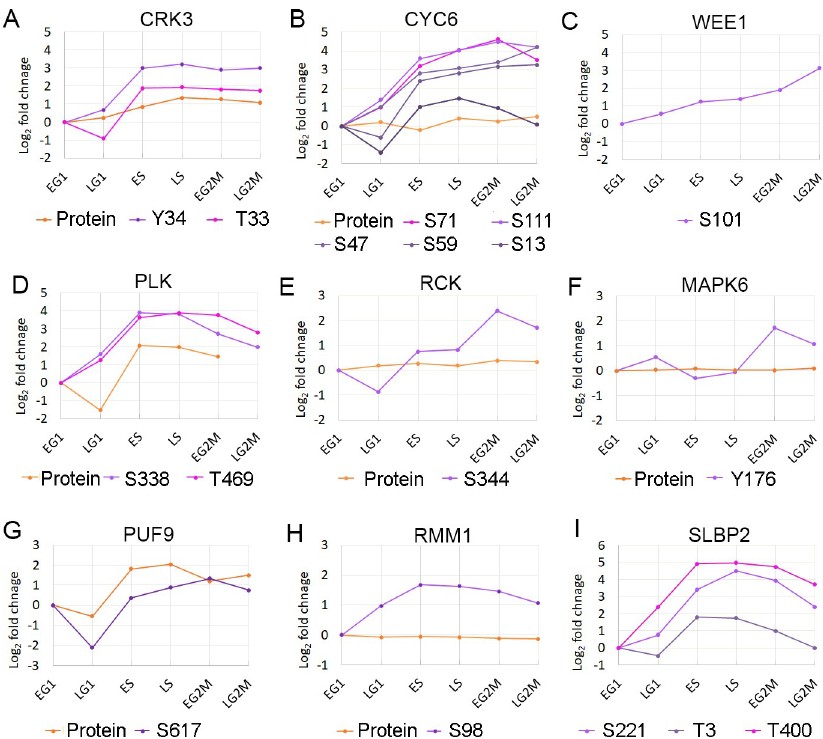
Fig 5. Cell cycle regulated protein kinases and RNA binding proteins. Changes in protein or phosphorylation site abundance relative to EG1. Orange–protein; Purple hues–phosphorylation sites. A. CRK3 protein, Y34 and T33. B. CYC6 protein, S13, S17, S111, S47 and S59. C. WEE1 S101. D. PLK protein, S338 and T469. E. RCK protein and S344. F. MAPK6 proteins and Y176, G. PUF9 protein and S617. H. RMM1 protein and S98. I. SLBP2 S221, T3 and T400. For clarity only CCR phosphorylation sites are